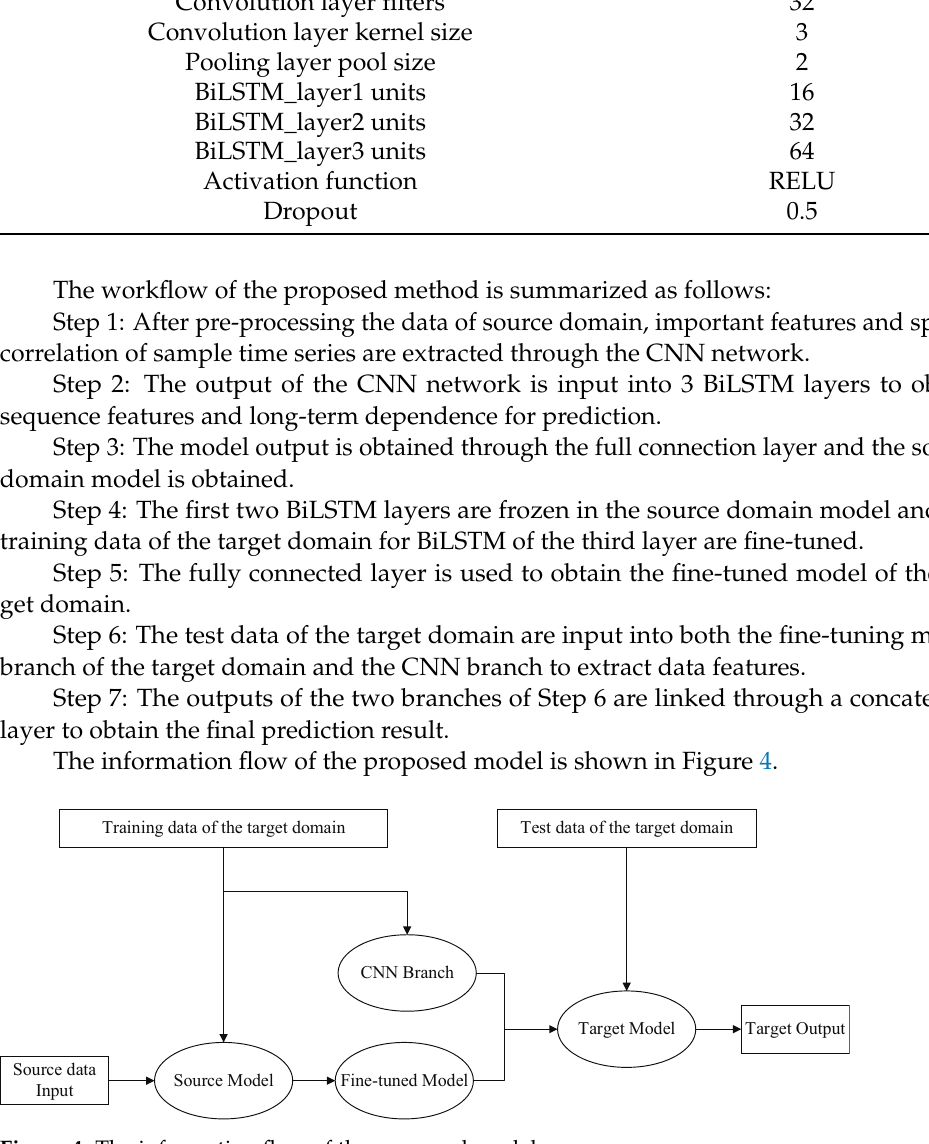
Figure 4. The information flow of the proposed